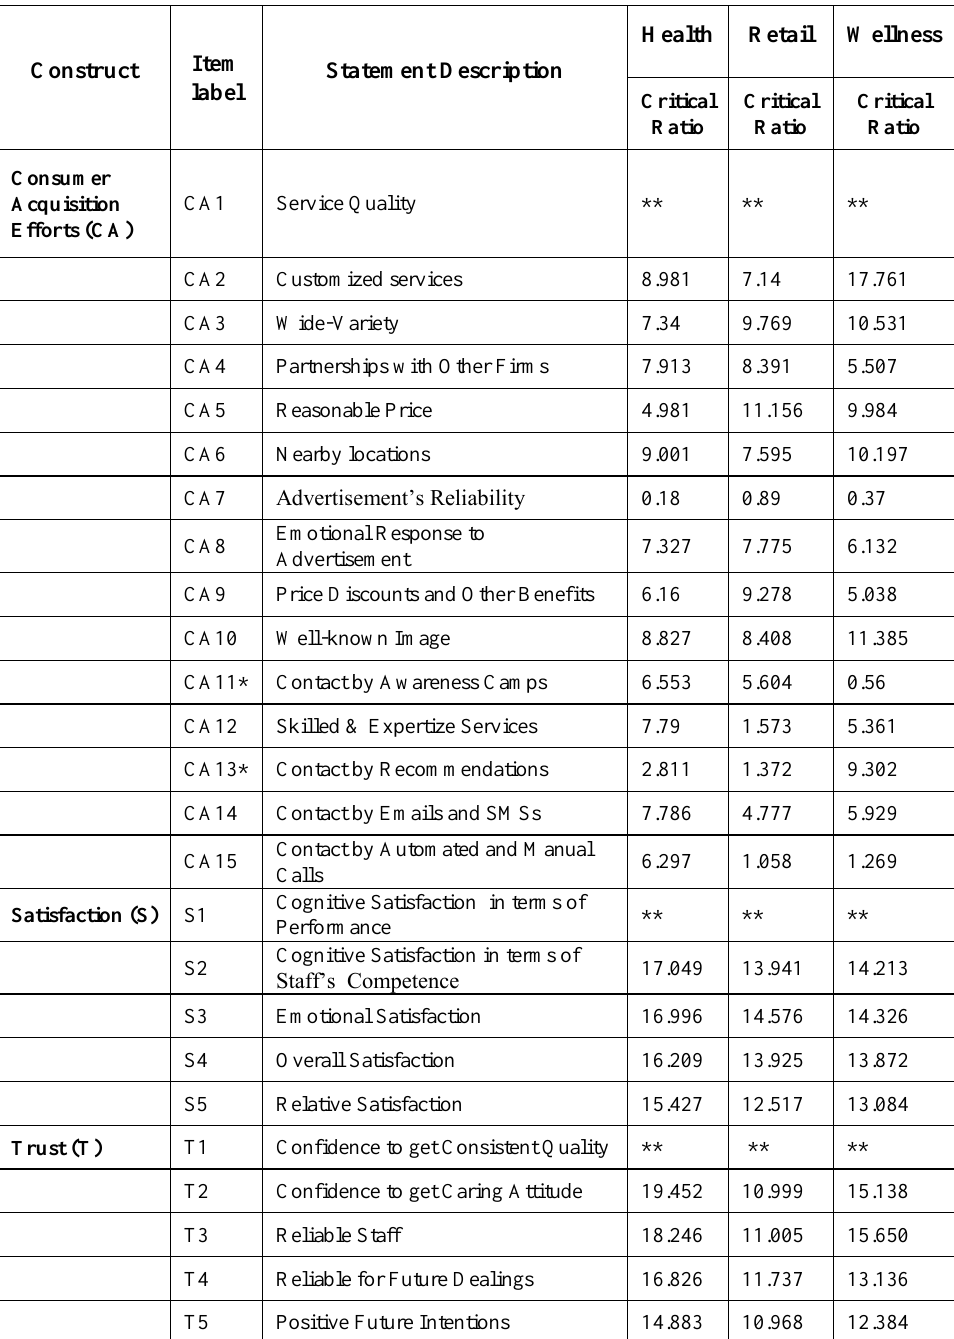
Table 02: CFA Results in Health, Retail, and Wellness